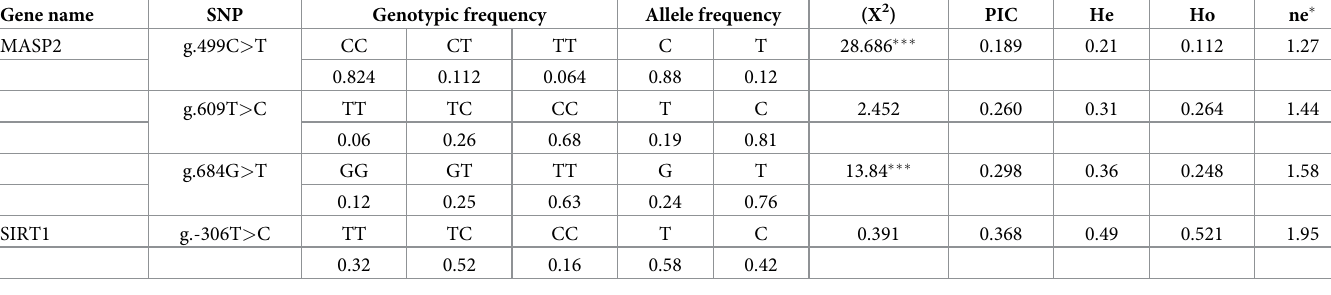
Table 3. The genotype, allelic frequencies and genetic diversity parameters in the MASP2 and SIRT1 genes for Sahiwal cattle. Gene